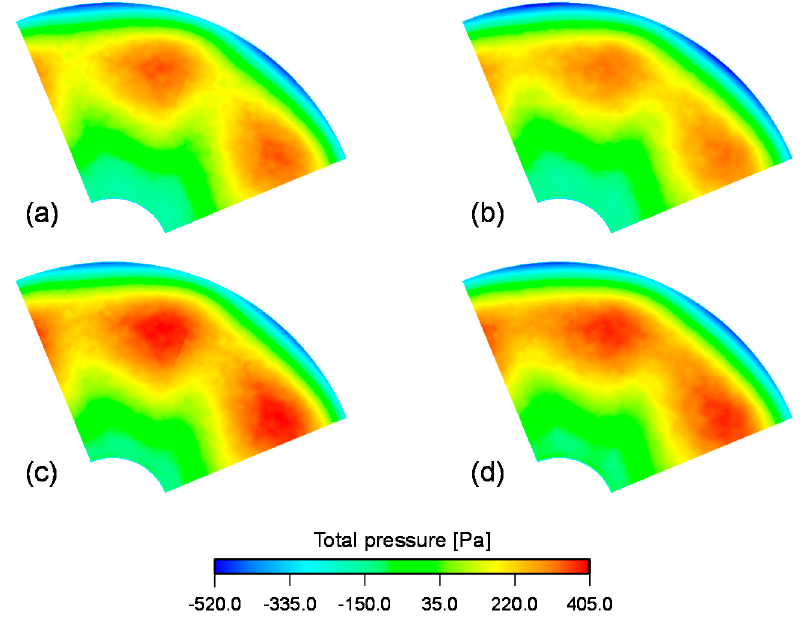
Figure 9. Total pressure contour in Plane 3 at 2700 rpm for: ( a ) 𝜃 = 6°, s = 120 mm; ( b ) 𝜃 = 6°, s = 200